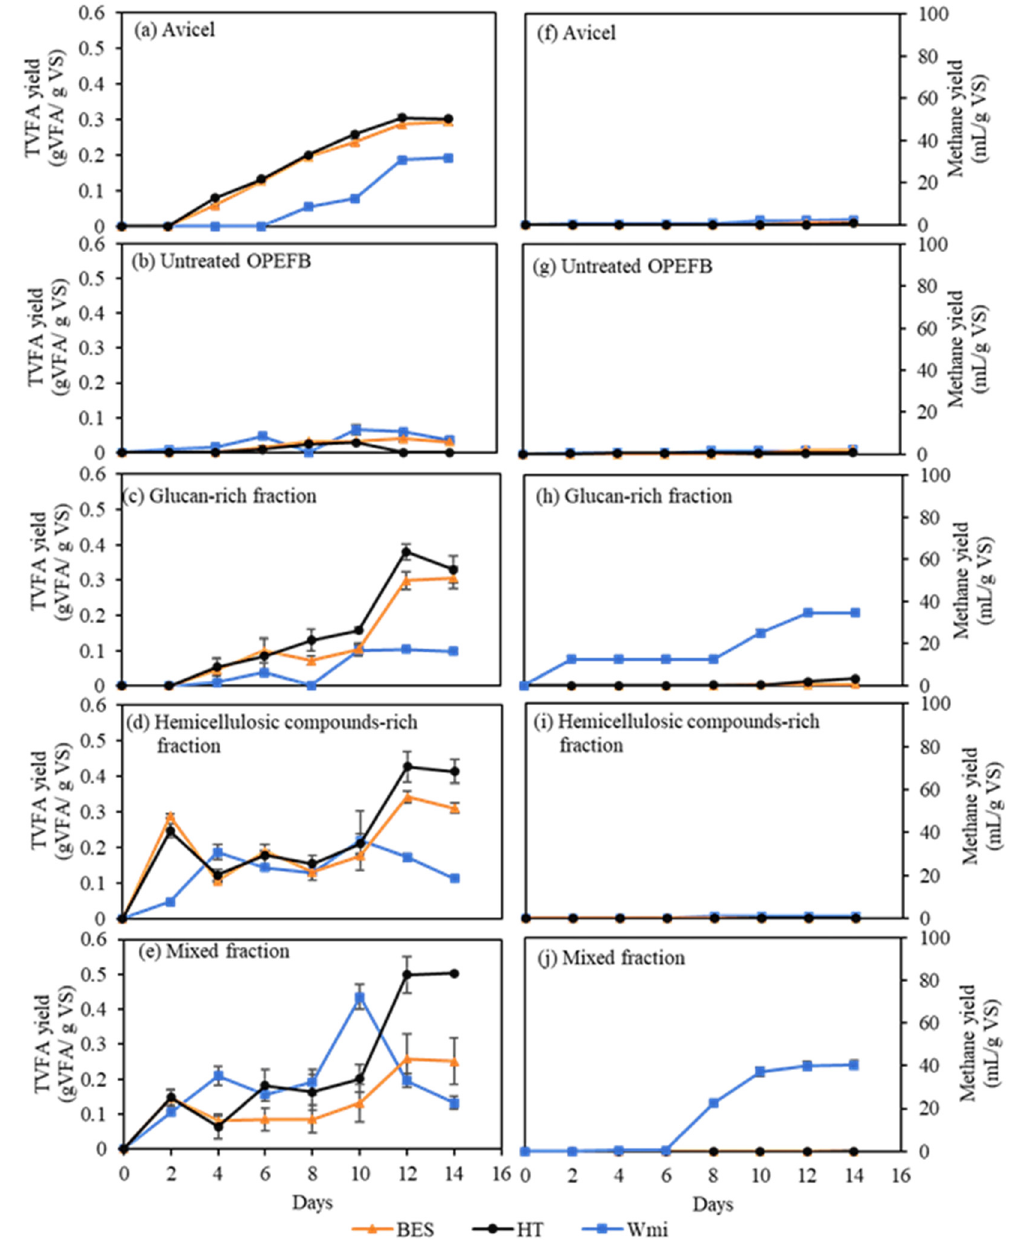
Figure 2. Total volatile fatty acid (TVFA) ( a – e ) and methane gas ( f – j ) yield during batch acidogenic fermentation of Avicel, untreated OPEFB, glucan-rich fraction, hemicellulosic compounds-rich fraction, and mixed fraction with or without methanogenesis inhibition. The experiments were done in triplicate. The abbreviations of the medium adjustment are: Wmi: without methanogenesis inhibition, BES: 2-bromoethanesulfonate, HT: heat-shock treatment.